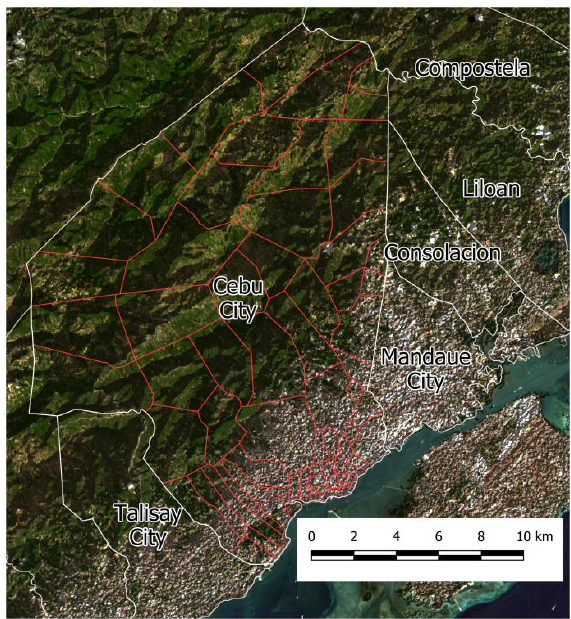
Figure 1. Satellite image of Cebu City showing the barangay boundaries (in red) and the adjacent cities and municipalities.